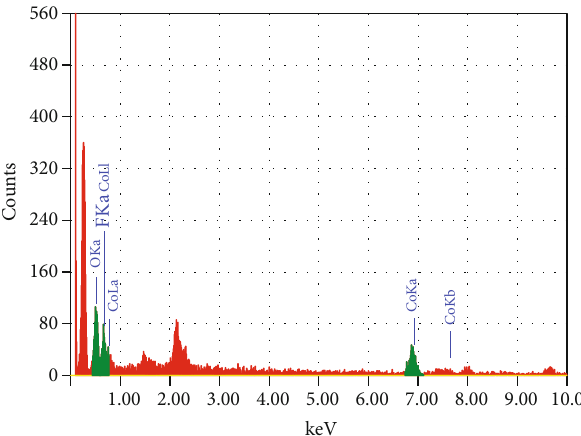
Figure 3: EDX spectrum of the prepared CoF